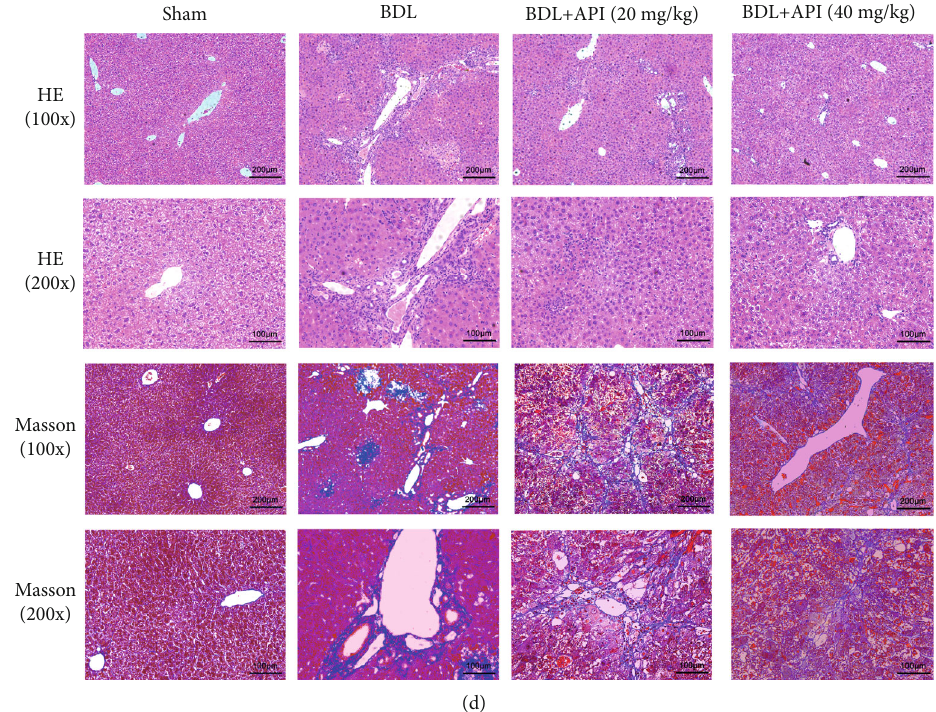
Figure 2: Apigenin protects the liver against fi brosis induced by CCl and BDL in mice. Notes: (a, b) the levels of serum ALT and AST are 4 (BDL) group vs. control group; # P < 0 : 05 for CCl (BDL)+apigenin (20 mg/kg) group vs. presented as mean ± SD ( n = 6 ; ∗ P < 0 : 05 for CCl 4 4 CCl (BDL) group; ! P < 0 : 05 for CCl (BDL)+apigenin (40 mg/kg) group vs. CCl (BDL)+apigenin (20 mg/kg) group). (c, d) Representative 4 4 4 H&E- and Masson-stained hepatic sections were examined under light microscopy and imaged at 200x and 100x magni fi